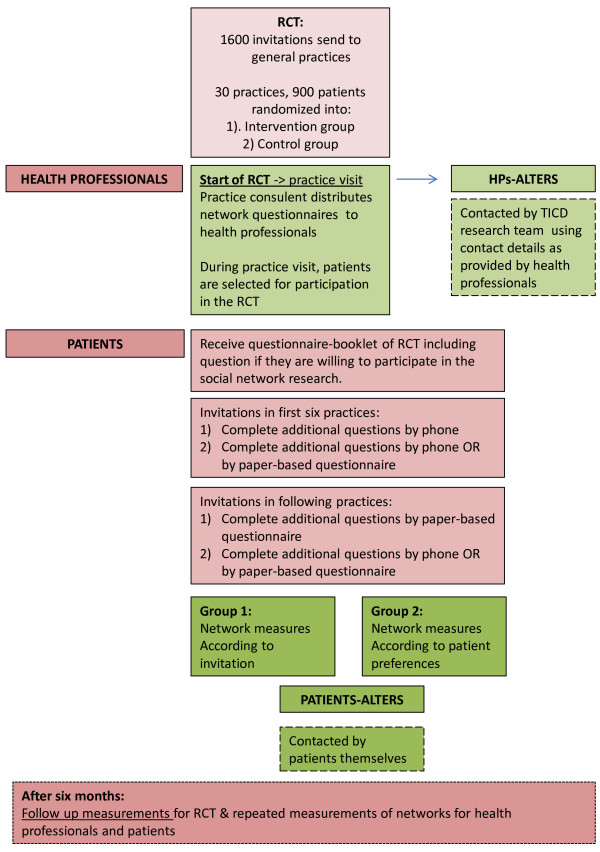
Study flow chart.